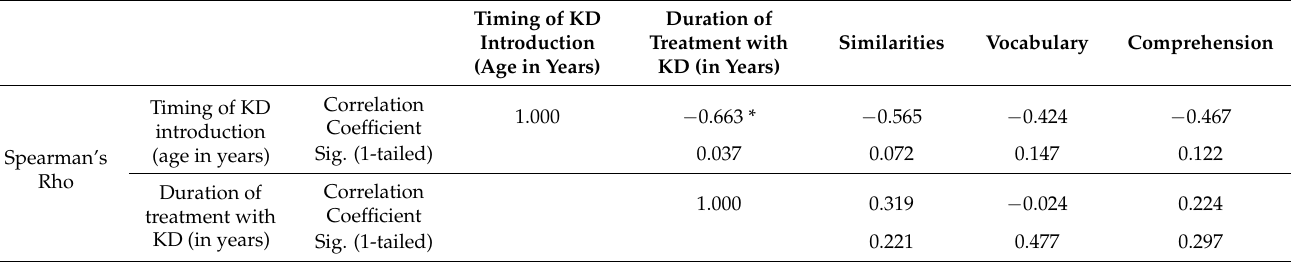
Table 7. Correlation between subtests of verbal comprehension index (VCI) and timing of